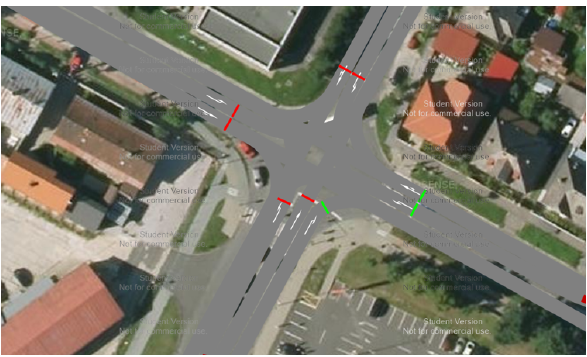
Figure 7: Traflc lights locations - current status